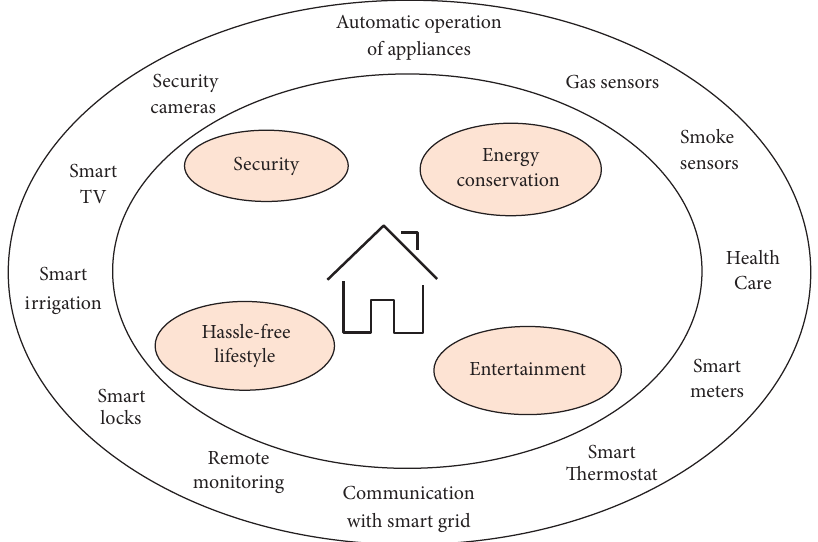
Figure 8: Block diagram of a smart home